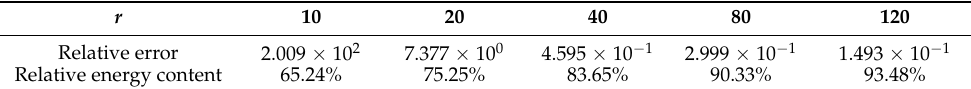
Table 2. Resolved, reconstructive regime. Relative L 2 errors (36) of the time-averaged streamfunction and relative energy content (30) for G-ROM with different r values.